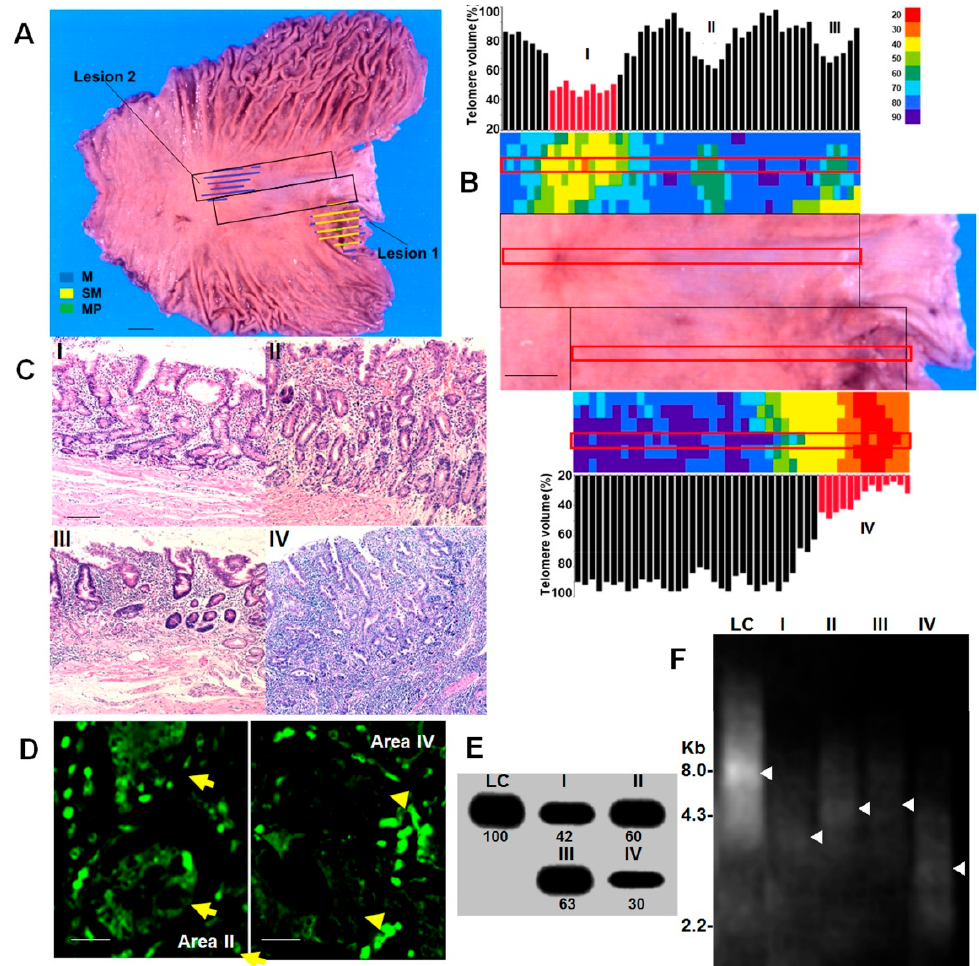
Figure 1. Short telomere lesion in gastric mucosa—Case 1. ( A ) Macroscopic image of mucosal aspect of the stomach with two gastric cancer lesions (Case 1 in Table 1). Scale bar, 1 cm. Boxes, TV examined areas showed in panel B, Color indicator, invasive depth and area. ( B ) TV of the gastric mucosa containing both gastric lesions. The heat map shows a geographical image of TV, and the bar graphs display the TV at the respective points in the area within the red box. Scale bar, 1 cm. ( C ) HE-stained tissue from areas I–IV indicated in panel B. Scale bar, 100 μ m. ( D ) Telomere FISH in area II and IV. Arrow, metaplastic glands. Arrow head, cancer galnds. Scale bar, 50 μ m. ( E ) TV by slot blot hybridization using (TTAGGG) 4 probe. LC, lymphocytes. Number, semi-quantified density. ( F ) Telomere length via Southern blot hybridization using (TTAGGG) 4 probe. LC, lymphocytes. Arrow head, peak density. M, mucosal layer; SM, submucosal layer; MP, muscularis propria layer; TV, telomere volume; HE, hematoxylin & eosin staining; FISH, fluorescent in situ hybridization. In case 3, a cancer lesion was observed in the antrum prepylorus, as shown in Figure 2A. A decrease in TV (47%) was observed in the cancer lesion (Figure 2B, area I). In addition, a focal reduction in TV was also seen in the non-cancerous mucosa, with a TV of 72% (area II). Examination of the tissue in each area revealed that the cancer could be classified as tub1 (well-differentiated tubular adenocarcinoma), remaining within the mucosa (Figure 2C). Area II showed intestinal metaplasia, and nuclear enlargement less than twice that of lymphocyte nuclei was observed within the lower 1/3 of the glands, with no structural